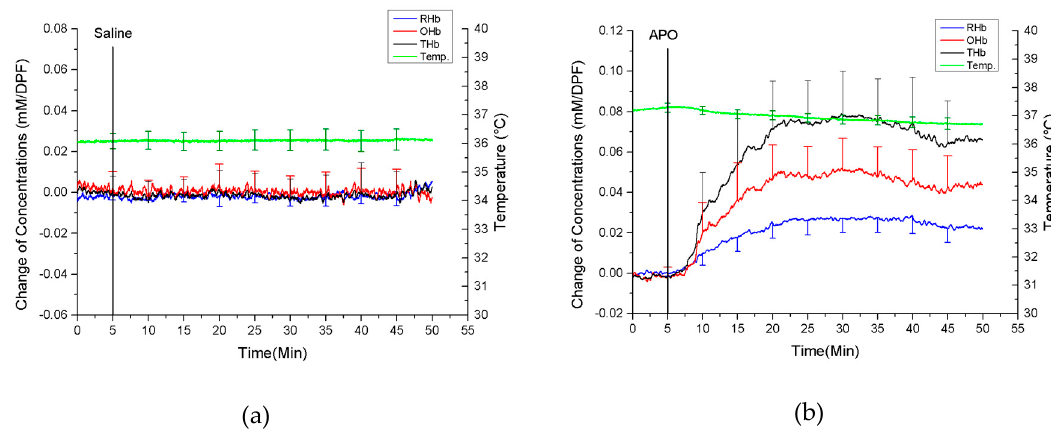
Figure 6. The average hemodynamic changes from all rats ( a ) Control group ( b ) APO group. (*RHb: deoxy-hemoglobin, OHb: oxy-hemoglobin, THb: total hemoglobin, mM: millimole, DPF: Differential path length factor).